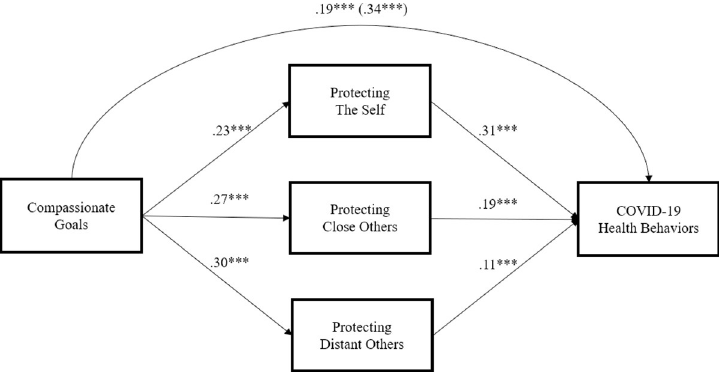
Fig 1. Mediation model controlling for gender, selfishness, and political ideology across three studies. All coefficients represent standardized effects. ��� p < .001.